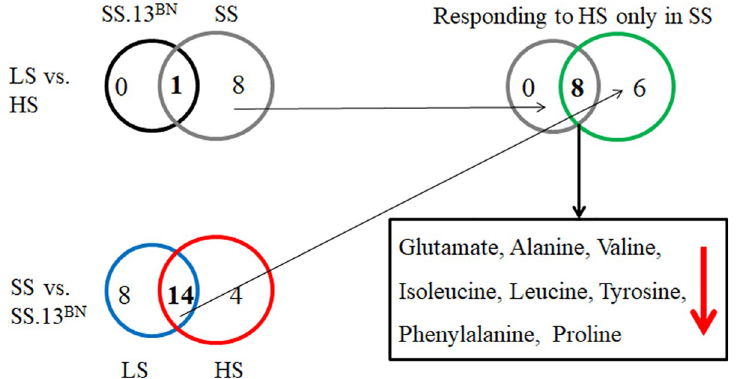
Fig 1. Numbers and overlaps of differentially ( p < 0.05) abundant amino acids in the serum of Dahl SS rats and SS.13 BN rats fed a low salt or high salt diet.